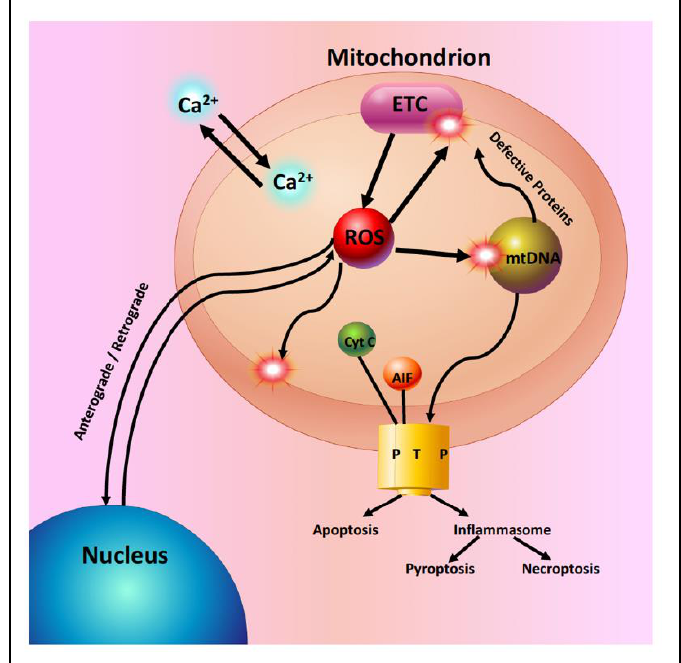
Figure 2. Mitochondria in the aging retina. Mitochondria are essential for many cellular functions including: (1) the synthesis of ATP by oxidative phosphorylation, (2) the regulation of intracellular calcium homeostasis, (3) anterograde and retrograde signaling between the nucleus and mitochondria, (4) the generation of reactive oxygen species (ROS) from the electron transport chain (ETC). ROS act as signaling molecules in low concentrations or as toxic molecules in higher concentrations. ROS oxidize mitochondrial lipids, proteins and DNA and (5) the regulation of apoptosis. Excess ROS or intramitochondrial calcium can lead to the activation of cell death pathways by opening the mitochondrial permeability transition pore (PTP).